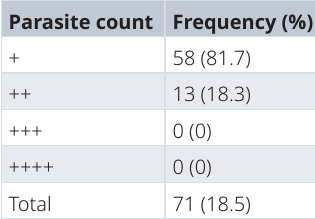
Table 3. Prevalence of malaria according to parasite count.